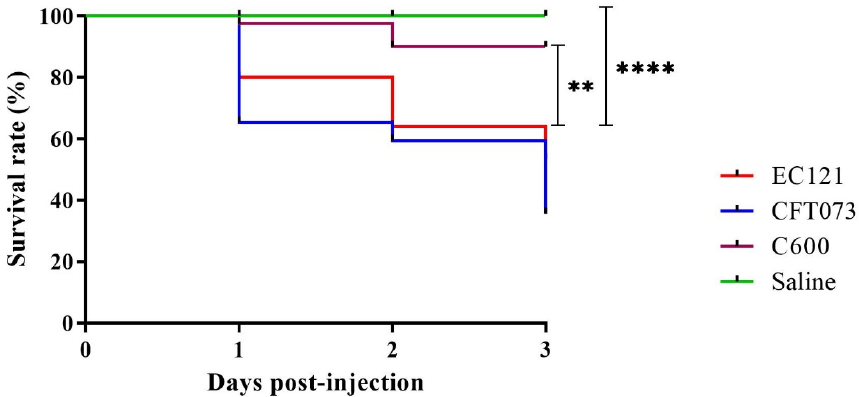
Figure 7. Galleria mellonella infection model. The virulence of EC121 was assessed using an inoculum of 10 4 CFU per G. mellonella larvae. The larvae survival rate, expressed by Kaplan–Meier plots indicated that EC121 was more virulent than the negative control (saline) and the nonpathogenic K-12 derived E. coli C600, while there was no significant difference between the survival rates of EC121 and the ExPEC prototype strain CFT073. p- value: ** < 0.005; **** < 0.0001). The assay was performed three times, with five larvae per group.